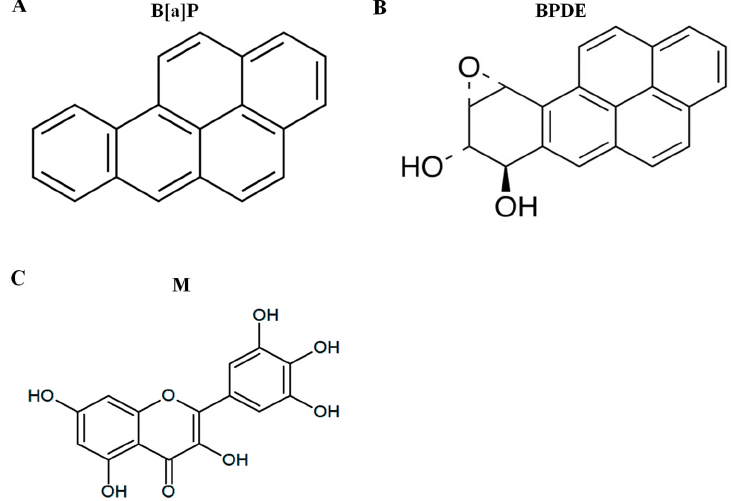
Figure1. Thestructureofchemicals. ( A )Benzo[a]pyrene(B[a]P),( B )B[a]P-7,8-dihydrodiol-9,10-epoxide (BPDE), and ( C )